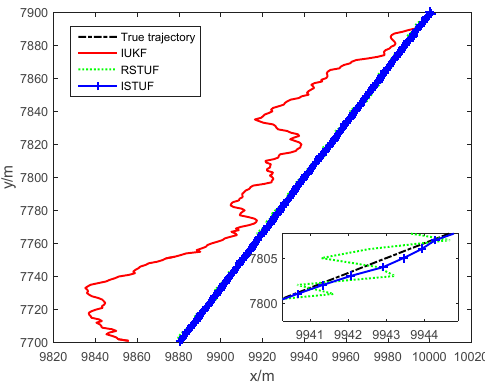
Figure 5. Comparison of the trajectories.